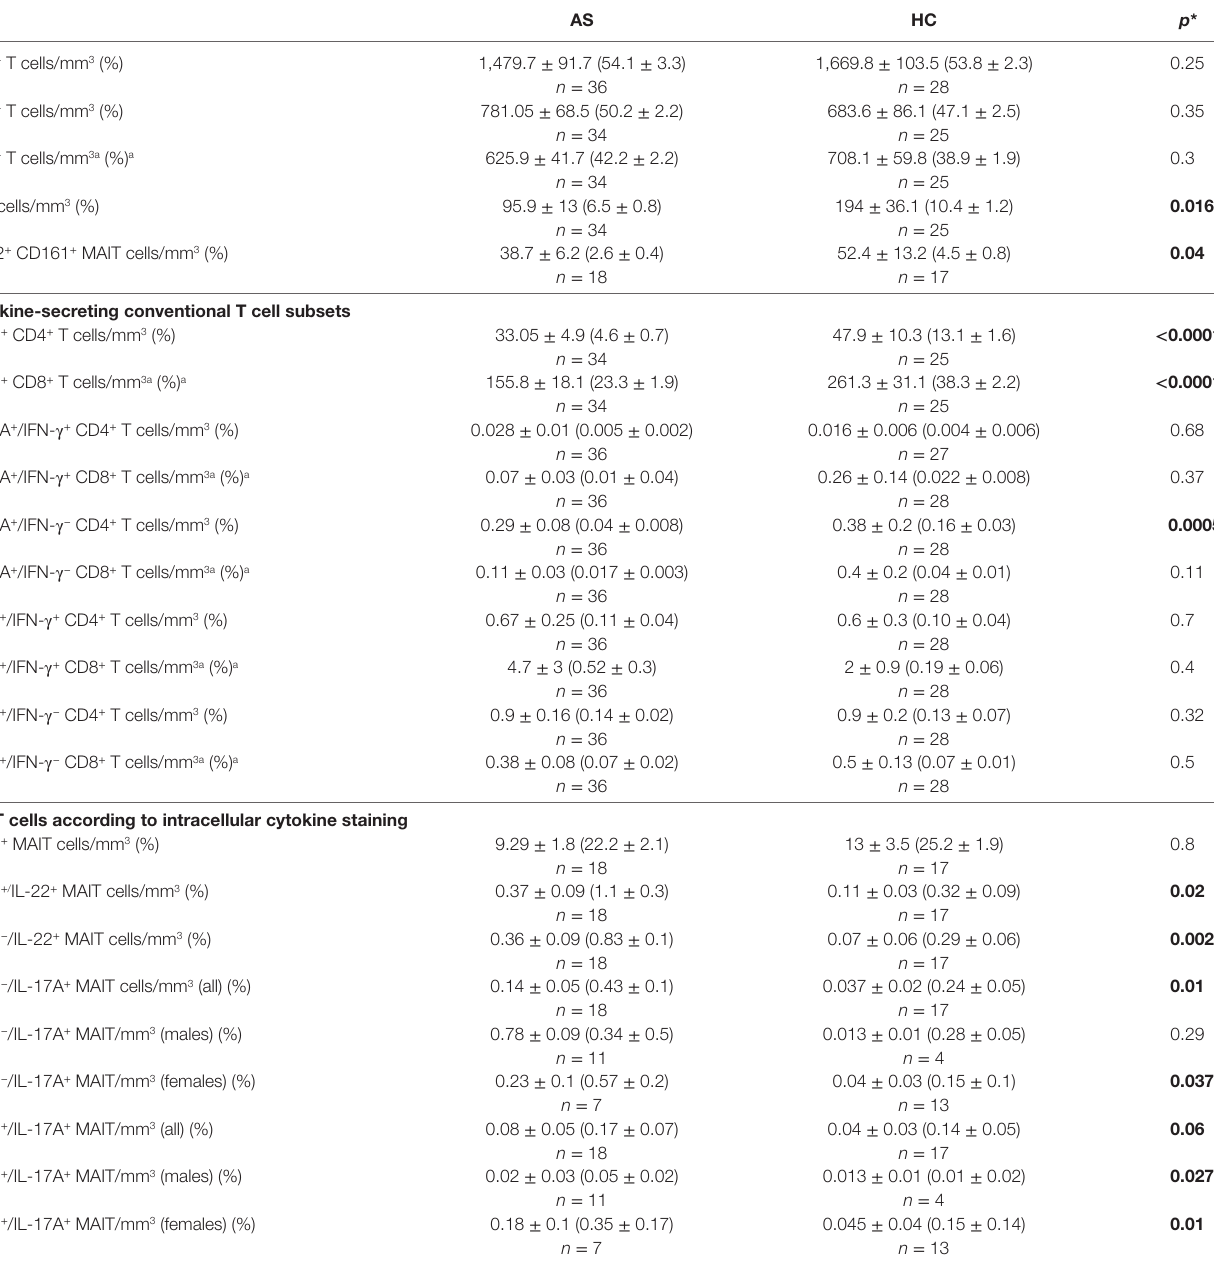
TaBle 2 | T cell subsets, cytokine-secreting helper T cells, and mucosal-associated invariant T (MAIT) cells in patients with ankylosing spondylitis (AS) ( n = 36) and healthy controls (HC) ( n = 55). as p